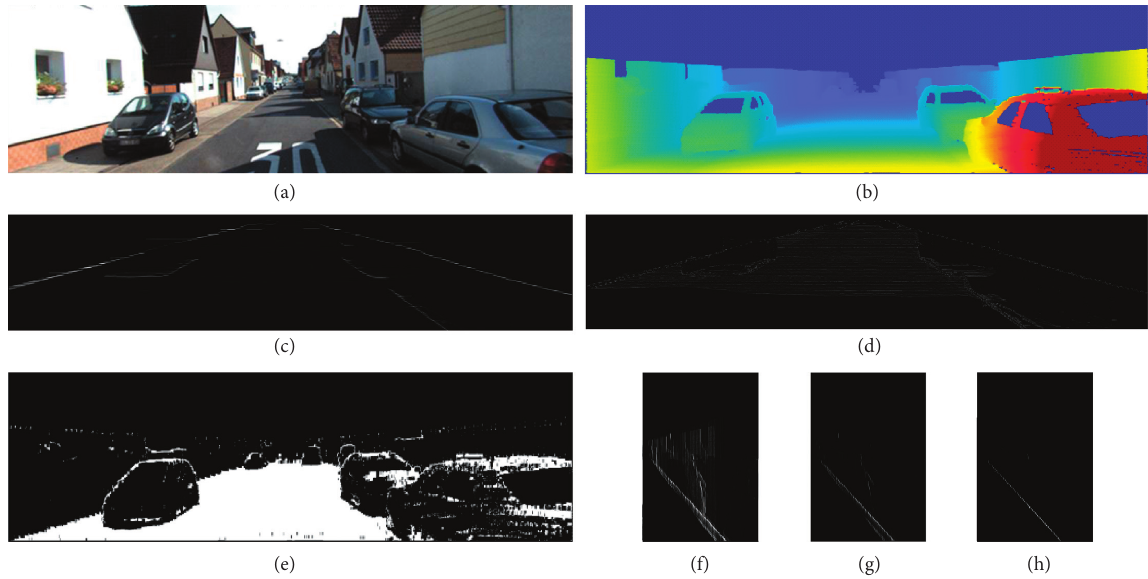
Figure 3: Considerate operation details of U and V views. (a) Original image. (b) Modified diaparity image. (c) Initial U view. (d) U view after removing obstacles (enlarged). (e) Diaparity image after removing obstacles. (f) Initial V view. (g) V view after removing obstacles. (h) Final V view.